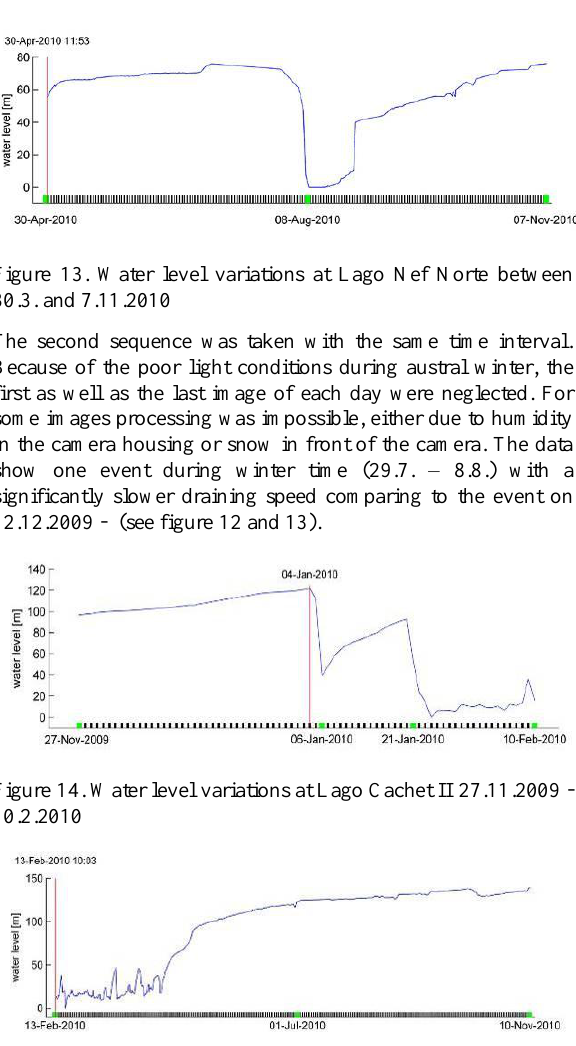
Figure 15. Water level variations at Lago Cachet II 13.2. -